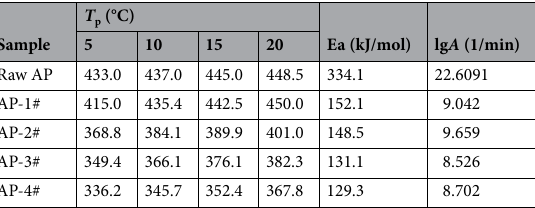
Table 2. The kinetic parameters for thermal decomposition of obtained samples.